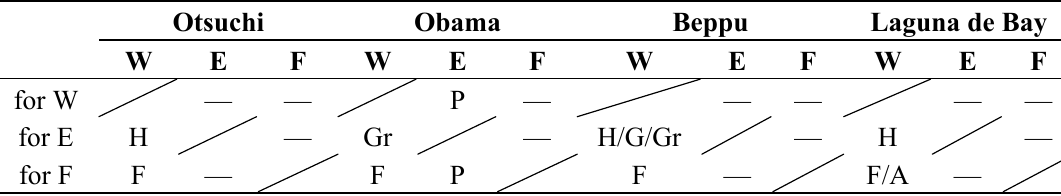
Table 1. Case study areas of RIHN WEFN project. Otsuchi Obama